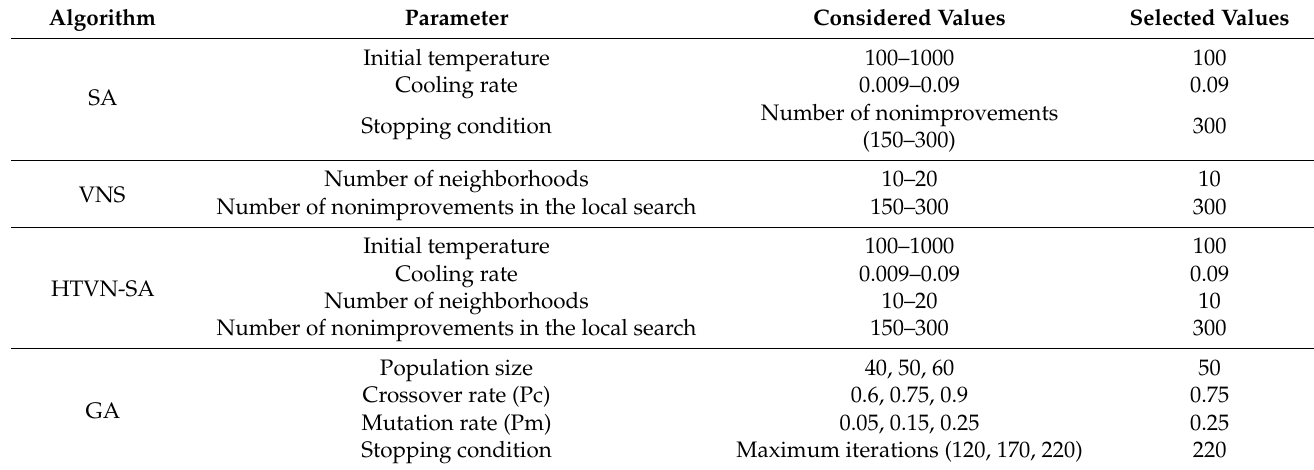
Table 7. The main parameters of other different